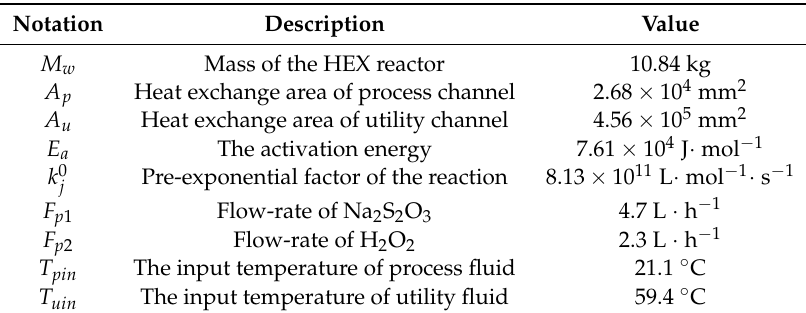
Table 1. Key information about the